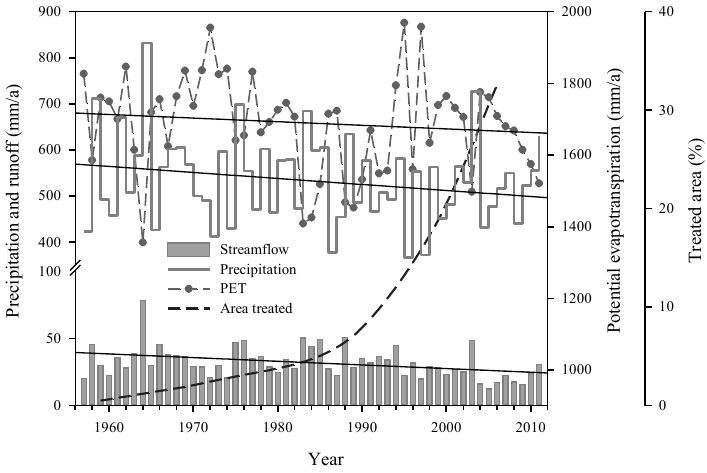
Figure 2. Annual precipitation, runoff, potential evapotranspiration (PET), and the area affected by soil conservation measures in the Beiluo River basin (Upper Zhuangtou station).